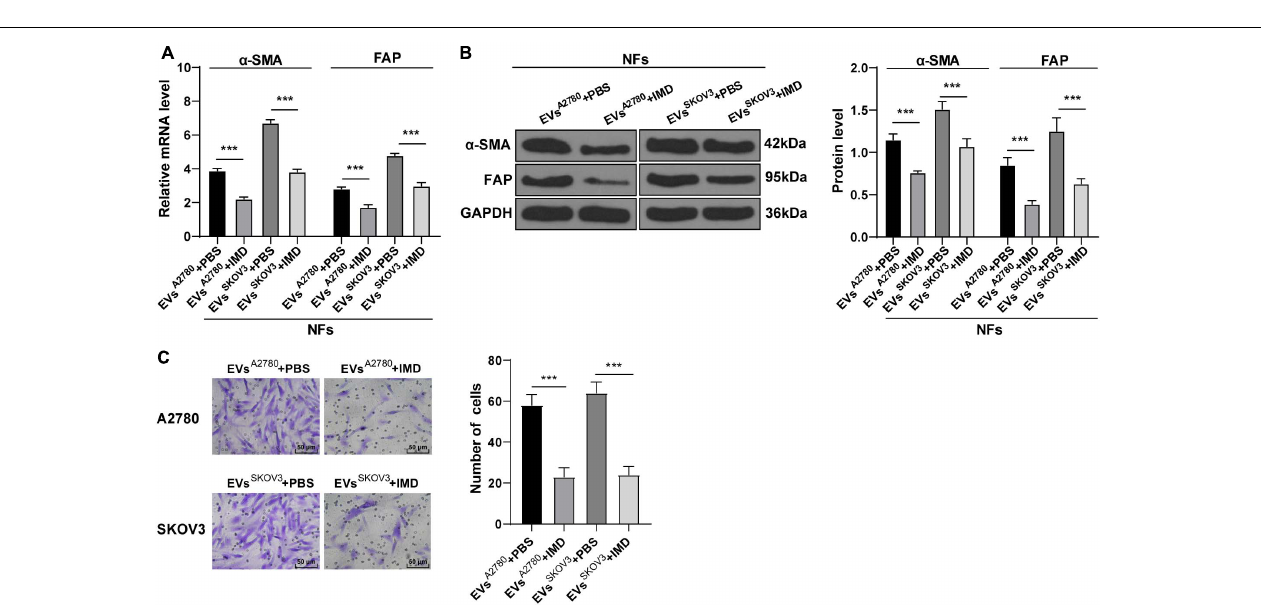
FIGURE 6 | Extracellular vesicles activated the NF- κ B pathway via the miR-630/KLF6 axis during CAF activation. (A,B) Expressions of p-p65, p65, p-I κ B α , and I κ B α in NFs were detected using RT-qPCR and Western blotting. The experiment was repeated three times independently. Data are presented as mean ± standard deviation and analyzed using one-way ANOVA, followed by Tukey’s multiple comparison test, ** p < 0.01. Note: A2780 and SKOV3 in the panel (B) indicated the source of EVs.